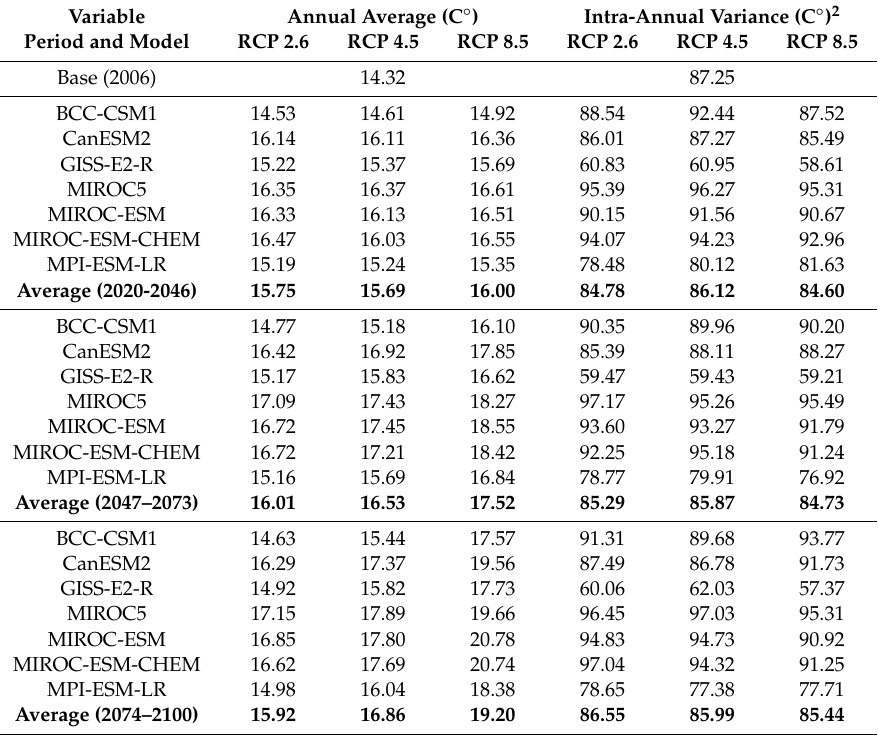
Table 5. Temperature predictions by climate model, emission scenario and future